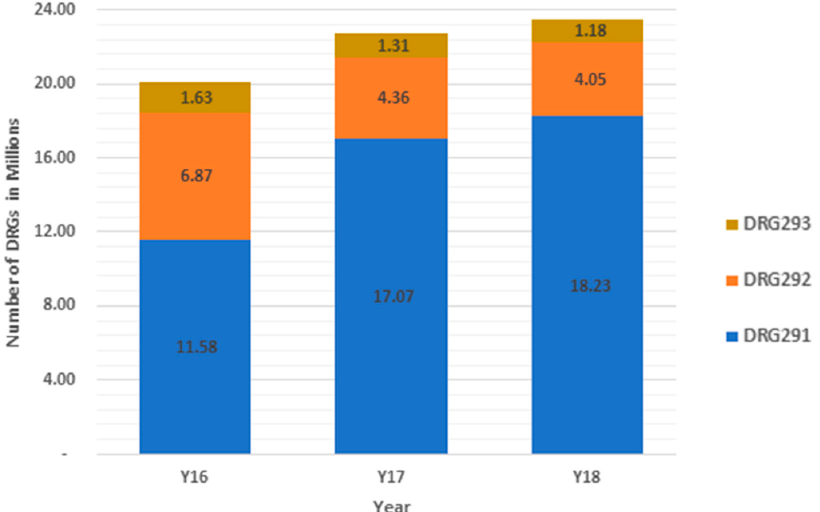
Figure 4. Number of DRGs by type (left axis) and cost estimates by DRG type and total, 2016 through 2018.